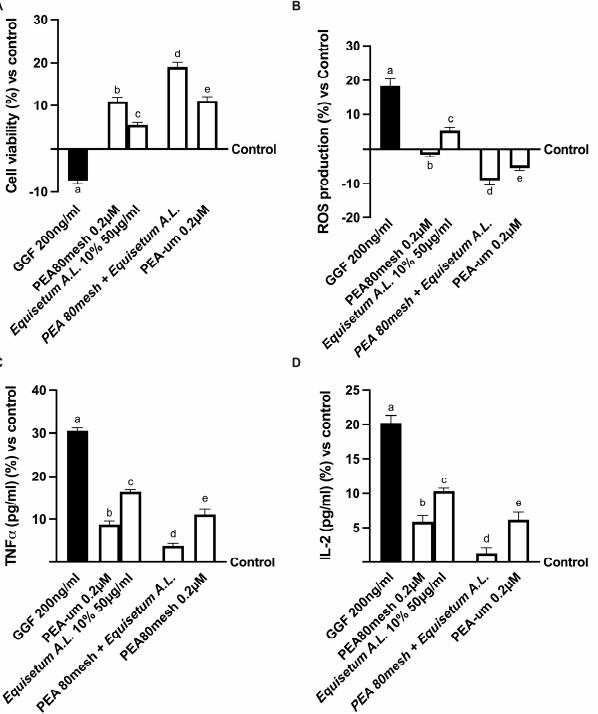
Figure 3. Analysis of PEA 80mesh plus Equisetum A.L. effects under PNI conditions In ( A ) mitochondrial metabolism by MTT; in ( B ) nerve growth factor (NGF) determination by ELISA test; in ( C ) TNFa quantification by ELISA test; and in ( D ) IL-1b analysis by ELISA test. The data are the means ± SD (%) of five independent experiments performed in triplicate and normalized to control values (0% line). GGF = glial growth factor 2; the other abbreviations are the same as those reported in Figure 1. In ( A ): a–e p < 0.05 vs. control; a p < 0.05 vs. b–e; b p < 0.05 vs. c, d; c p < 0.05 vs. d, e; d p < 0.05 vs. e. In ( B ): a, c–e p < 0.05 vs. control; a p < 0.05 vs. b–e; b p < 0.05 vs. c, d; c p < 0.05 vs. d, e; d p < 0.05 vs. e. In ( C ): a–c, e p < 0.05 vs. control; a p < 0.05 vs. b–e; b p < 0.05 vs. c, d, e; c p < 0.05 vs. d, e; d p < 0.05 vs. e. In ( D ): a, b, c, e p < 0.05 vs. control; a p < 0.05 vs. b, c, d, e; b p < 0.05 vs. c, d; c p < 0.05 vs. d, e; d p < 0.05 vs. e.